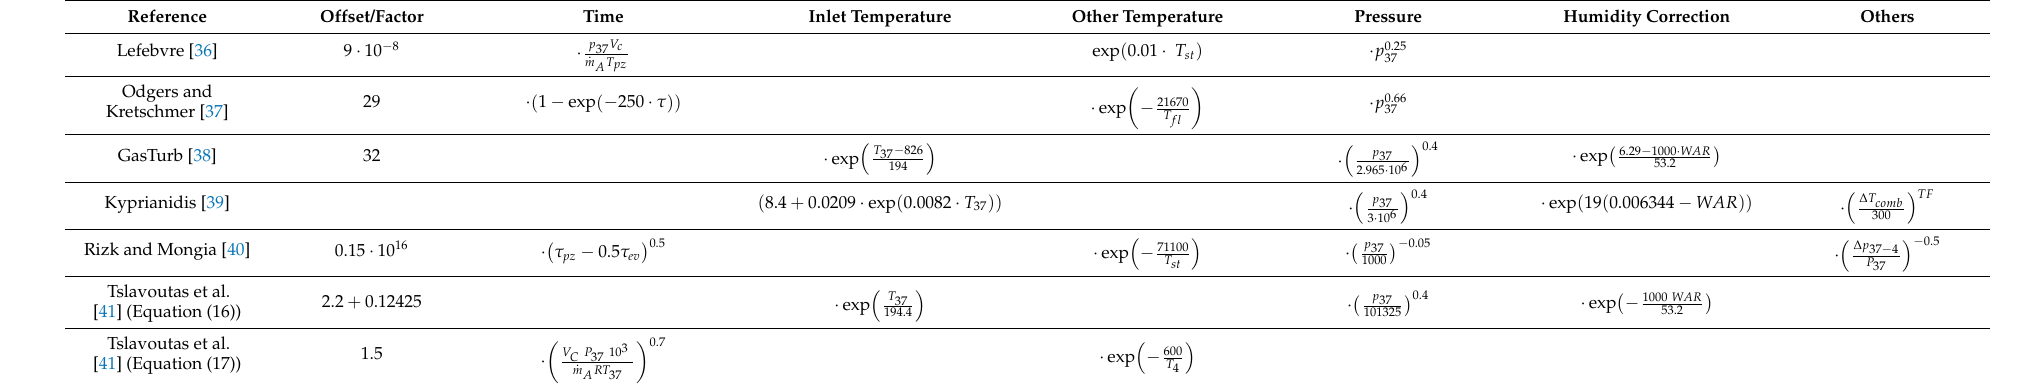
Table 2. NO x emission correlations in the form of EI NOx [g/kg] for (conventional) aero engine combustors. All variables are to be inserted in SI-units. The units of all constants are neglected here for simplicity. p 37 is the combustor inlet pressure, T 37 the combustor inlet temperature, T 4 is the combustor outlet temperature, T st is the stoichiometric flame temperature, T pz is the primary zone temperature, T fl is the flame temperature, V c is the combustor volume, is the water air ratio, ∆ T comb is the combustion temperature difference, TF is a technology factor, τ is the residence time, τ pz is the residence time in the primary zone, τ ev is the fuel evaporation time, R is the specific gas constant, and ∆ p 37 − 4 is the pressure difference between combustor inlet and